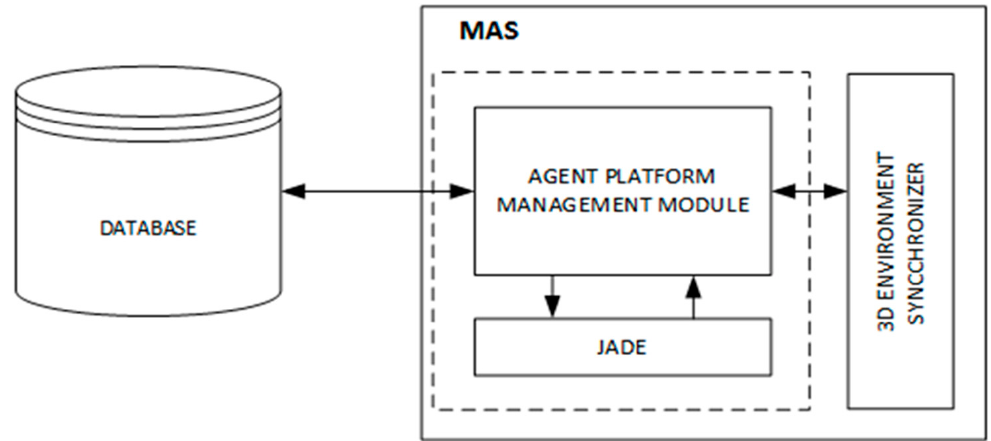
Figure 2. Multi-agent system (MAS) Components.